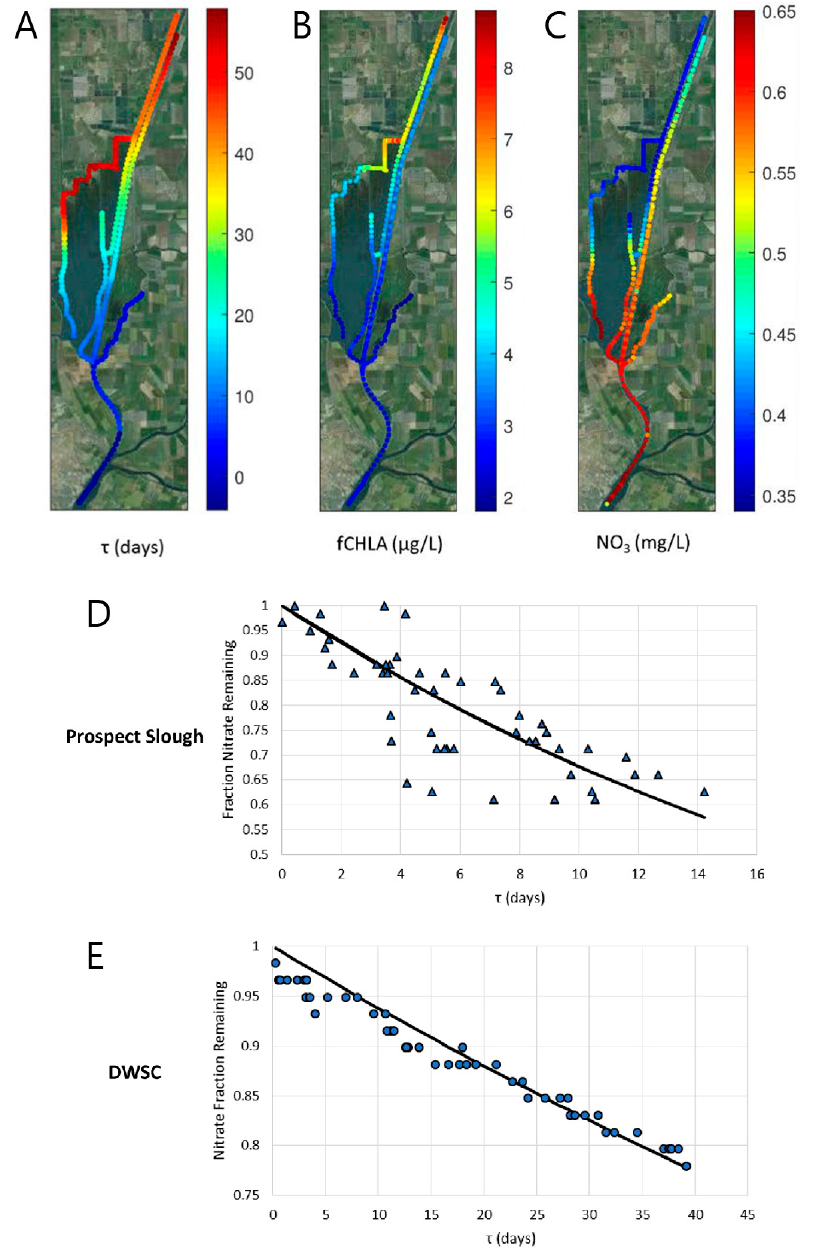
Figure 9. ( A ) Water age “ τ ”, ( B ) chlorophyll a fluorescence, and ( C ) nitrate, based on